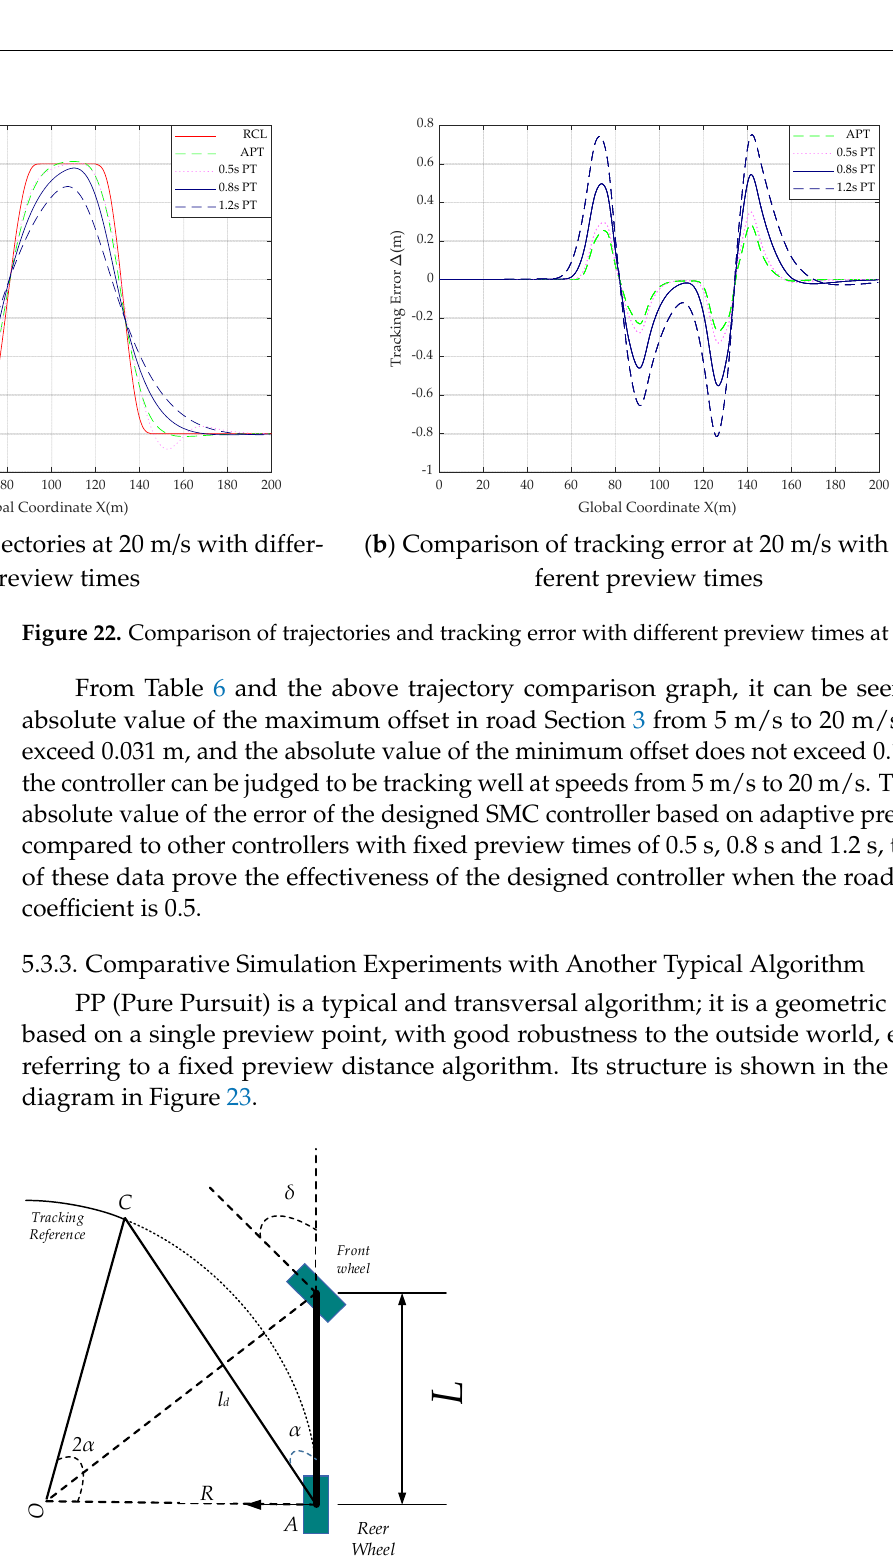
Figure 23. Structural diagram of the PP algorithm, where δ is front wheel steering angle; L is wheelbase of vehicle; l d is preview distance; draw the circle using the preview distance as the chord length of the circle, and R is the radius of the circle; the circle intersects the trajectory at point C ; α is the angle of the chord to the vehicle body.